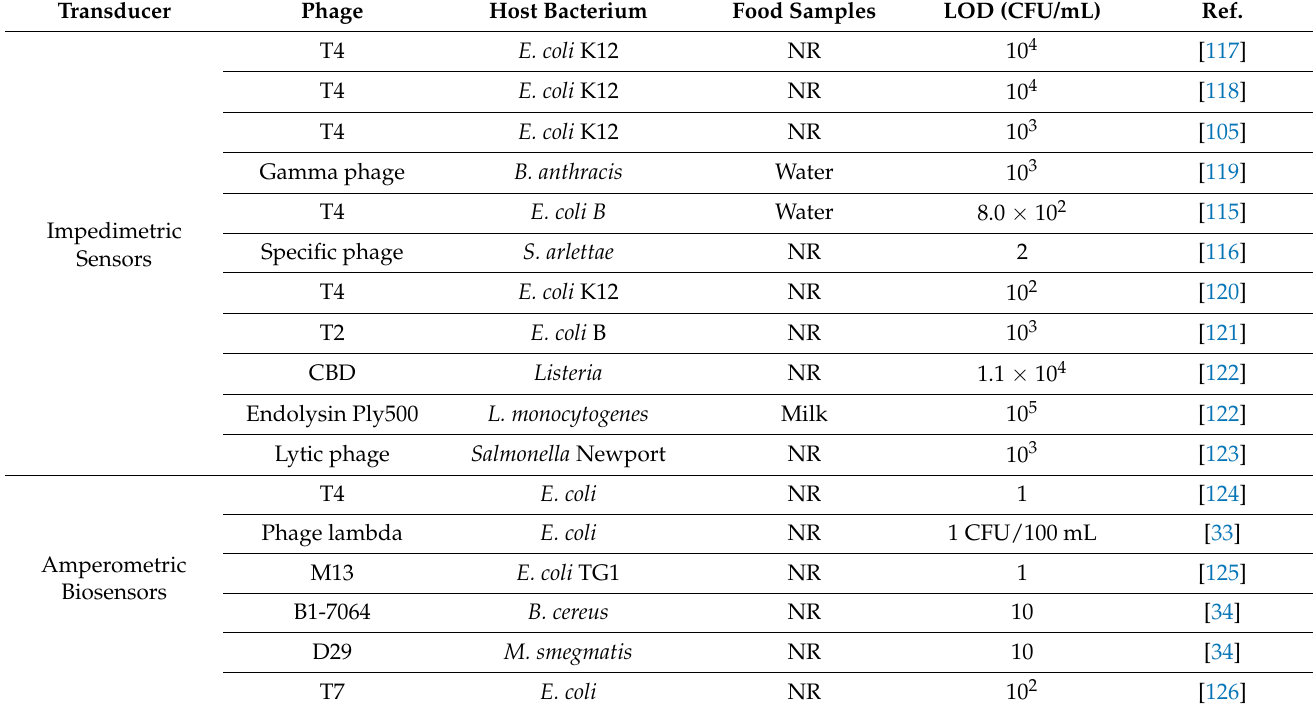
Table 2. Some examples of phage-based electrochemical